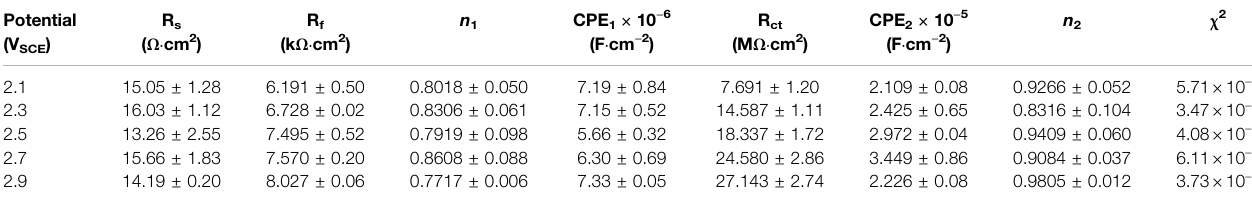
TABLE 2 | Fitting results of electrochemical impedance spectra for as-cast Ti – 6Al – 4V after OCP tests in Hank ’ s solutions at 37 ° C. R resistance, R ct indicateschargetransferresistance,CPE 1 andCPE 2 describe fi lmcapacitanceandchargetransfercapacitance, n 1 and n 2 aretheexponentsofCPE 1 and CPE 2 , and χ 2 is the sum of the square of the difference between theoretical and experimental